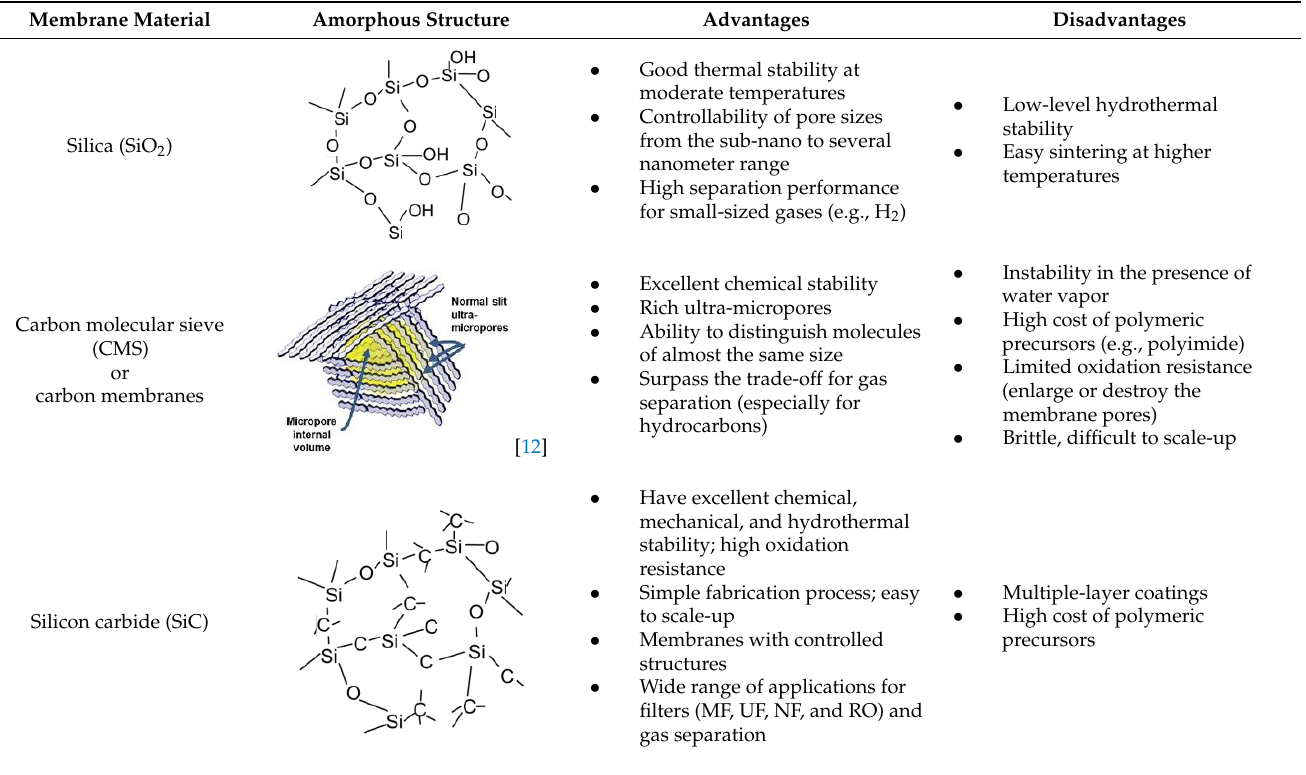
Table 1. Advantages and disadvantages of inorganic membranes with amorphous structures.